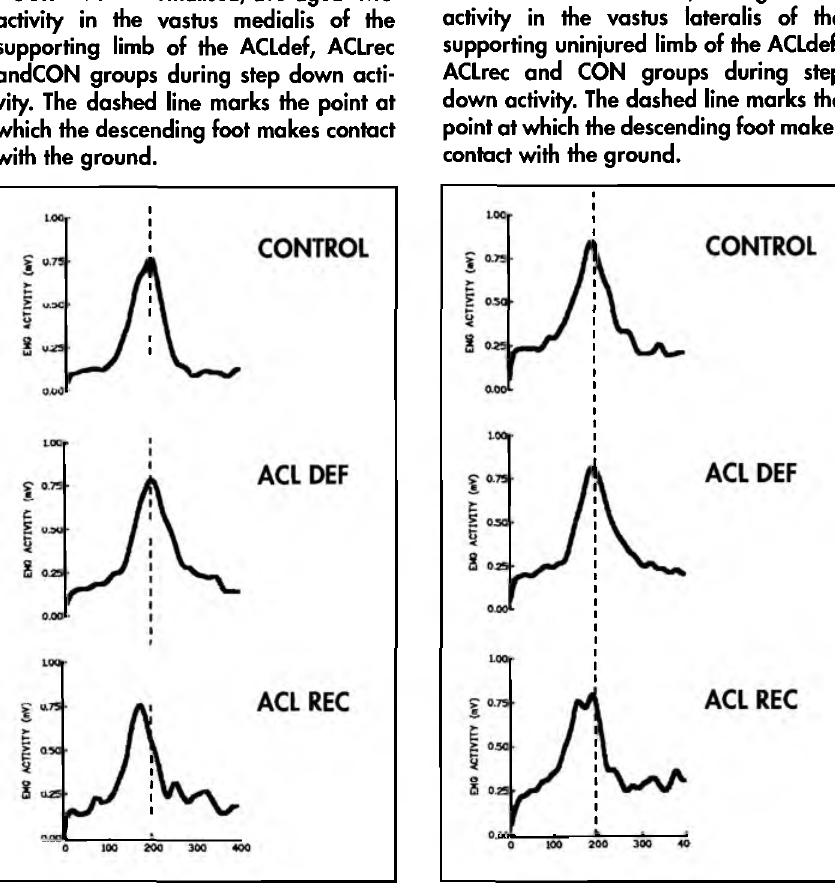
FIGURE 3. The normalised, averaged EMG activity in the vastus lateralis of the supporting uninjured limb of the ACLdef, ACLrec and CON groups during step down activity. The dashed line marks the point at which the descending foot makes contact with the